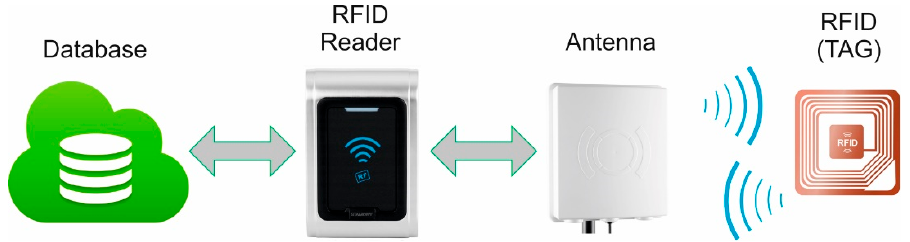
Figure 4. The structure of the system using RFID tags.